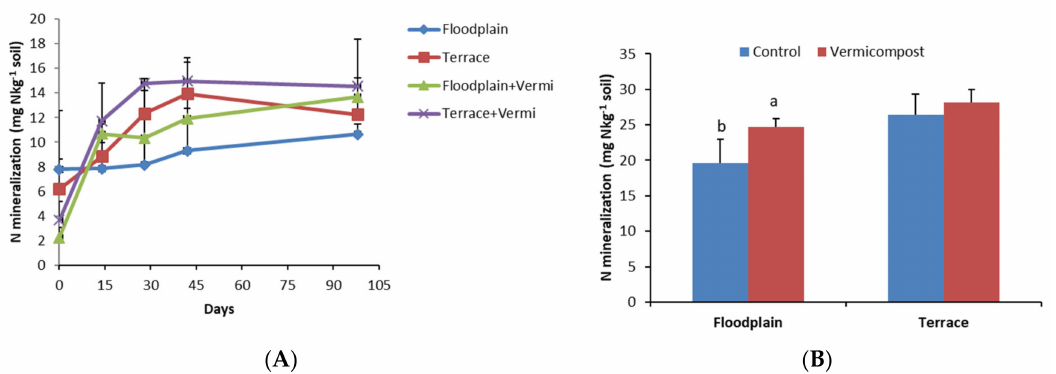
Figure 2. Trend of NH 4+ -N release pattern from vermicompost-amended soils during incubation study for a period of 14 weeks ( A ); N mineralization in two contrasting soils after 98 days ( B ) as influenced by vermicompost amendment.